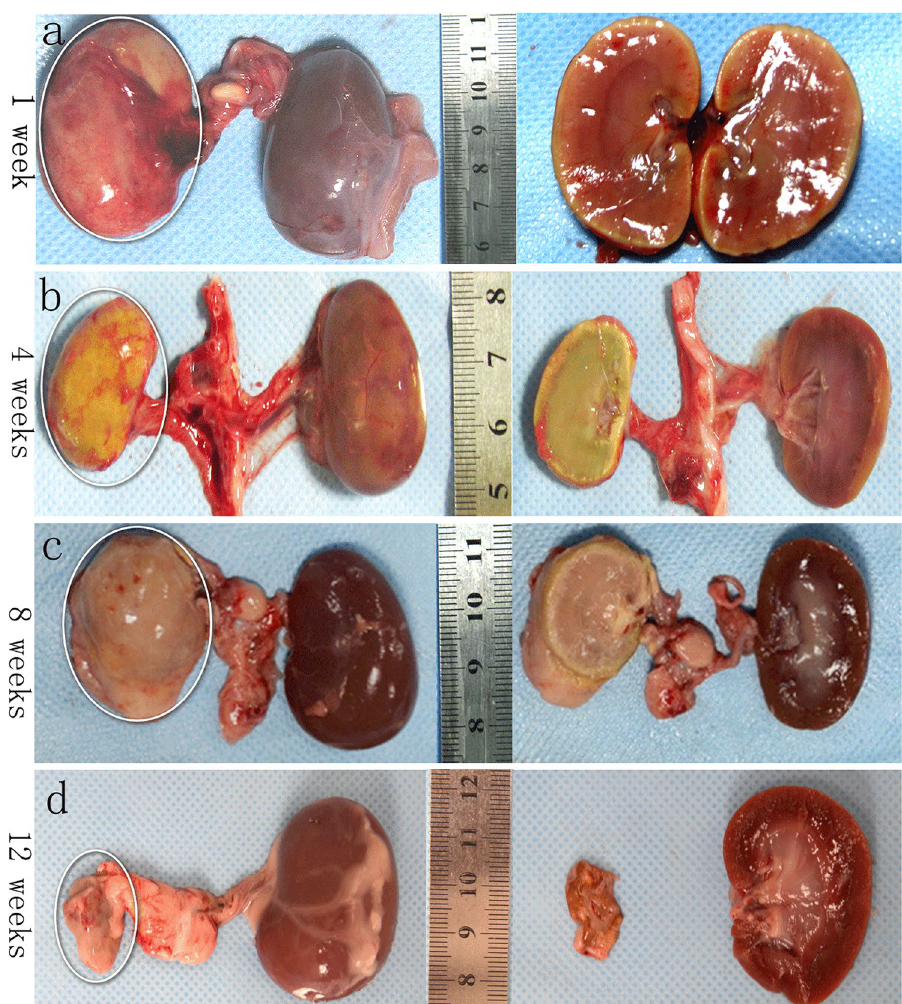
Figure 5. Macro-pathological pictures of the right kidneys of the rabbits after embolization at four various time points. ( a – d ) The images show that the right kidney gradually shrank after embolization, and the left kidney enlarged in a compensatory